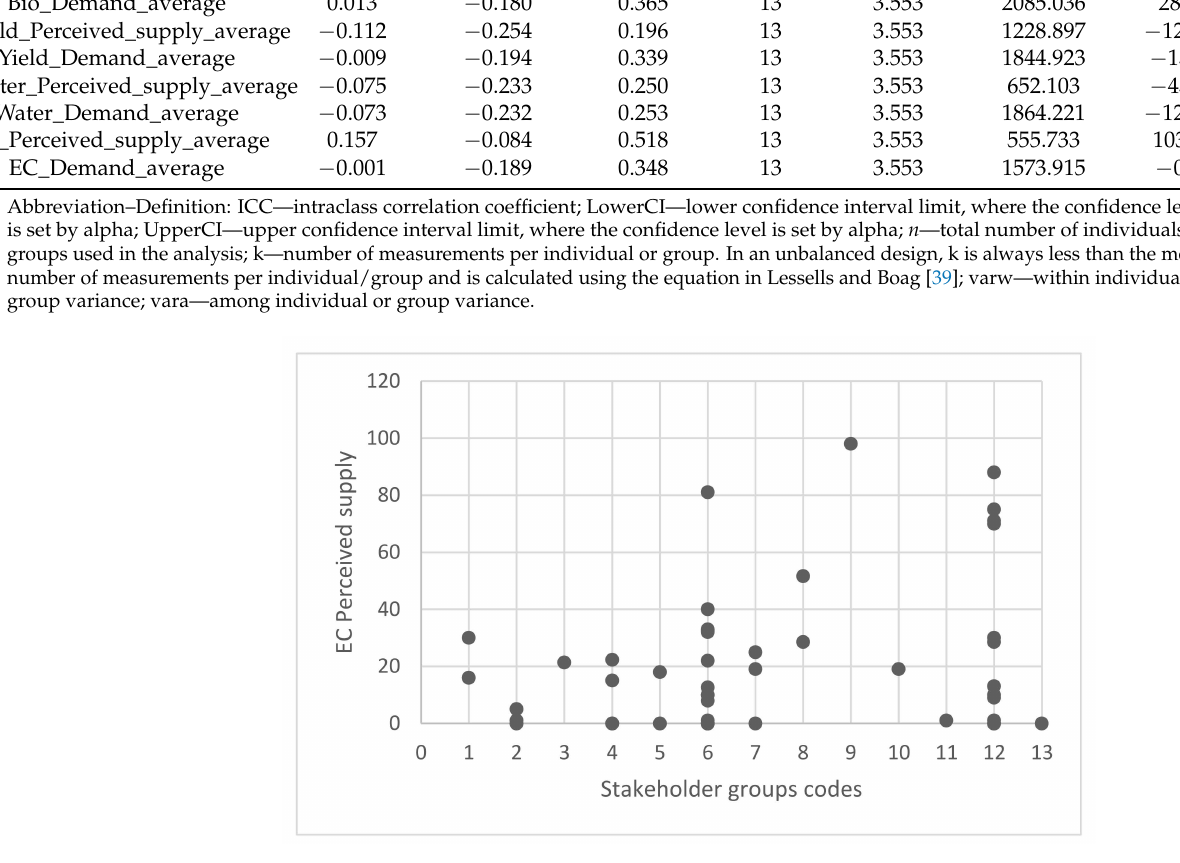
Figure 3. Scatter plot between the supply of erosion control (EC) perceived and coded stakeholder groups to display the correlation between the two